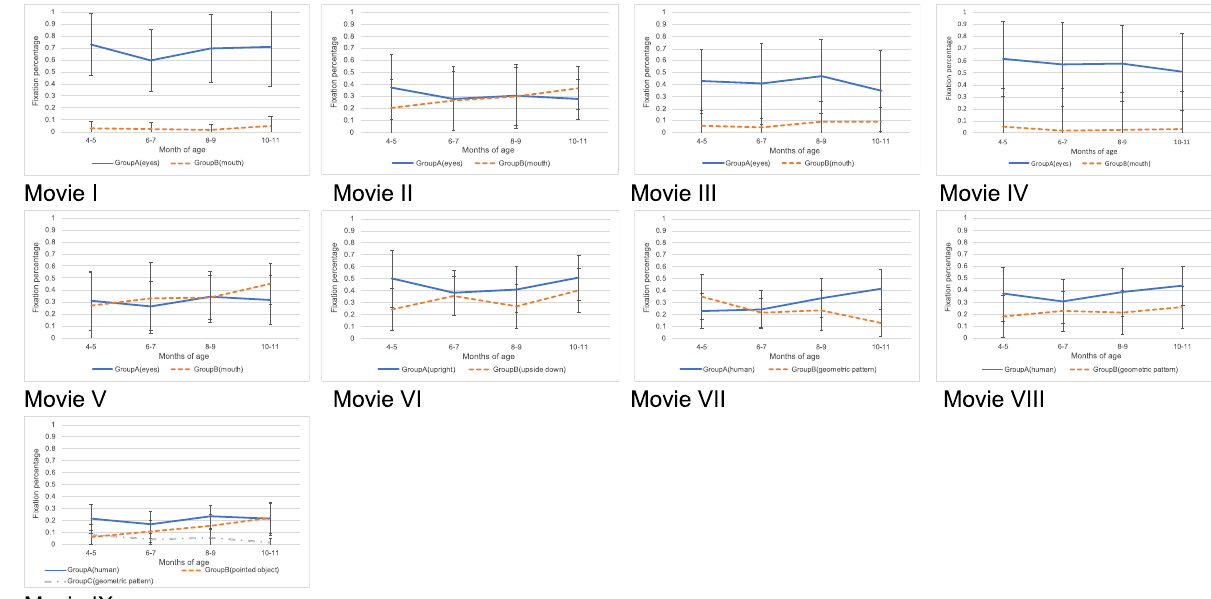
Figure 3. Transition of the fixation percentages allocated to the particular areas in each age group. Line graphs of the percentage fixation times and standard deviations of each age group. Movie I–V; human face; (I) eye blinking; (II) mouth moving; (III) still image; (IV) silent; (V) talking; Movie VI; biological motion; Movie VII; human and geometric patterns (same size) VIII; human and geometric patterns (small window), Movie IX; joint attention. SD standard